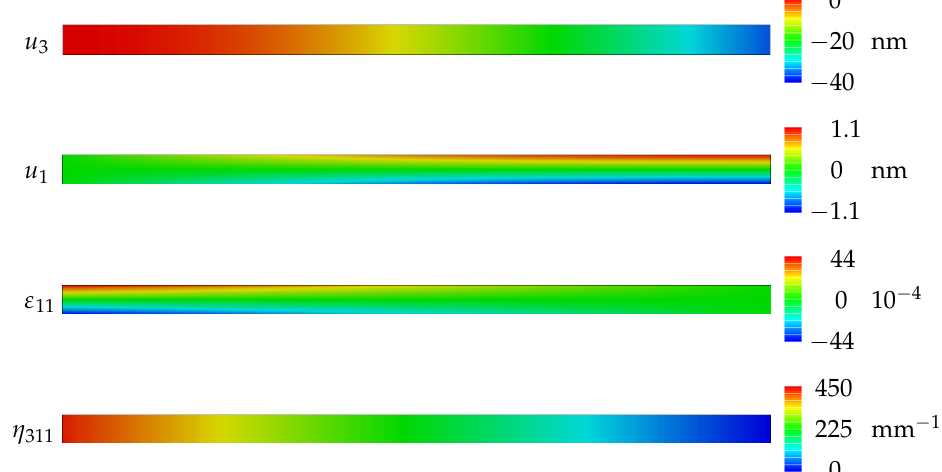
Figure 5. Deflections u 3 and u 1 , mechanical strain ε 11 , and mechanical strain gradient η 311 distribution along the cantilever